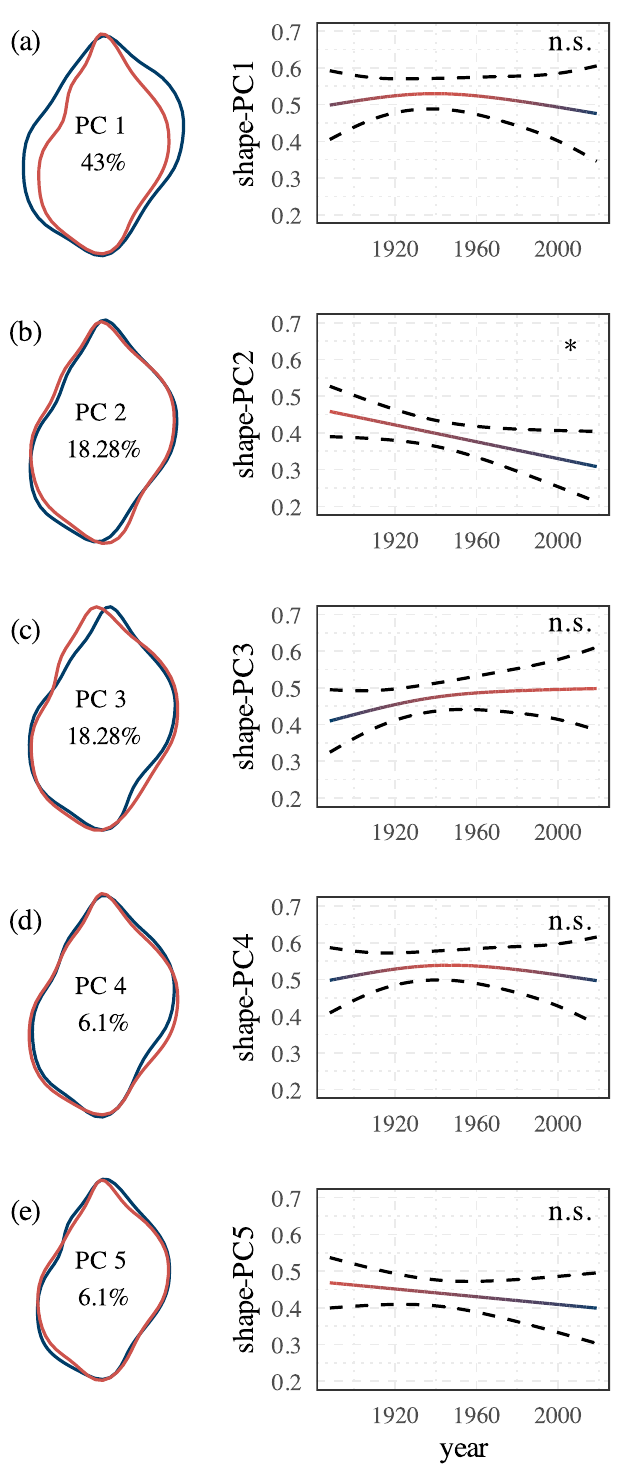
Fig. 2 Shell shape trends presented for the fi rst fi ve shape descriptors. a Shape-PC1, b shape-PC2, c shape-PC3, d shape-PC4, and e shape-PC5 in the intertidal gastropod Nucella lapillus from the Belgian and Dutch coast collected between 1888 and 2019. Shape variance ( x ± 3 σ ) encompassed in either shape-PC is presented as outline The biggest percentage increase was in the 15 °C temperature threshold group showing that there were more than twice as many days reaching sea surface temperatures of 15 °C in 2019 than in 1880.